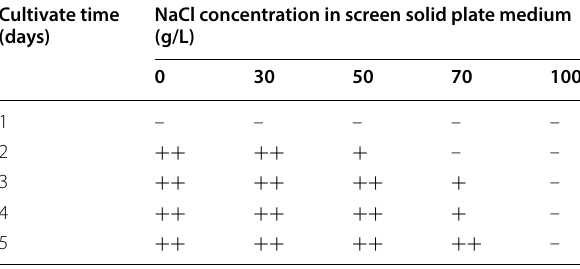
Table 2 Growth of strain F1 in screen solid plate medium with different salinity treatments